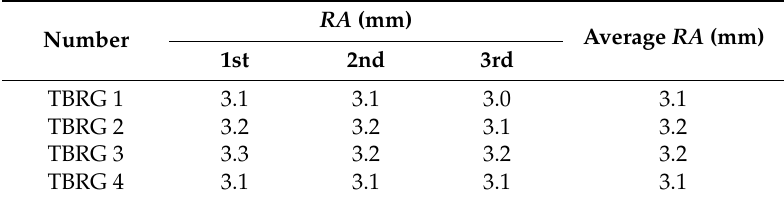
Table 3. Measurement accuracy of tipping-bucket rain gauges (TBRGs) assessed over three trials under the laboratory flow-type rainfall intensity standard device testing. 1st, 2nd, and 3rd refer to the measurement time series.